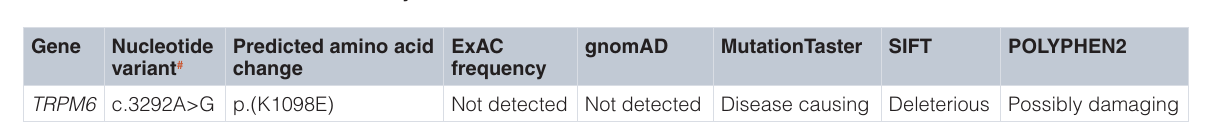
Table 2. TRPM6 variant and in silico analysis.